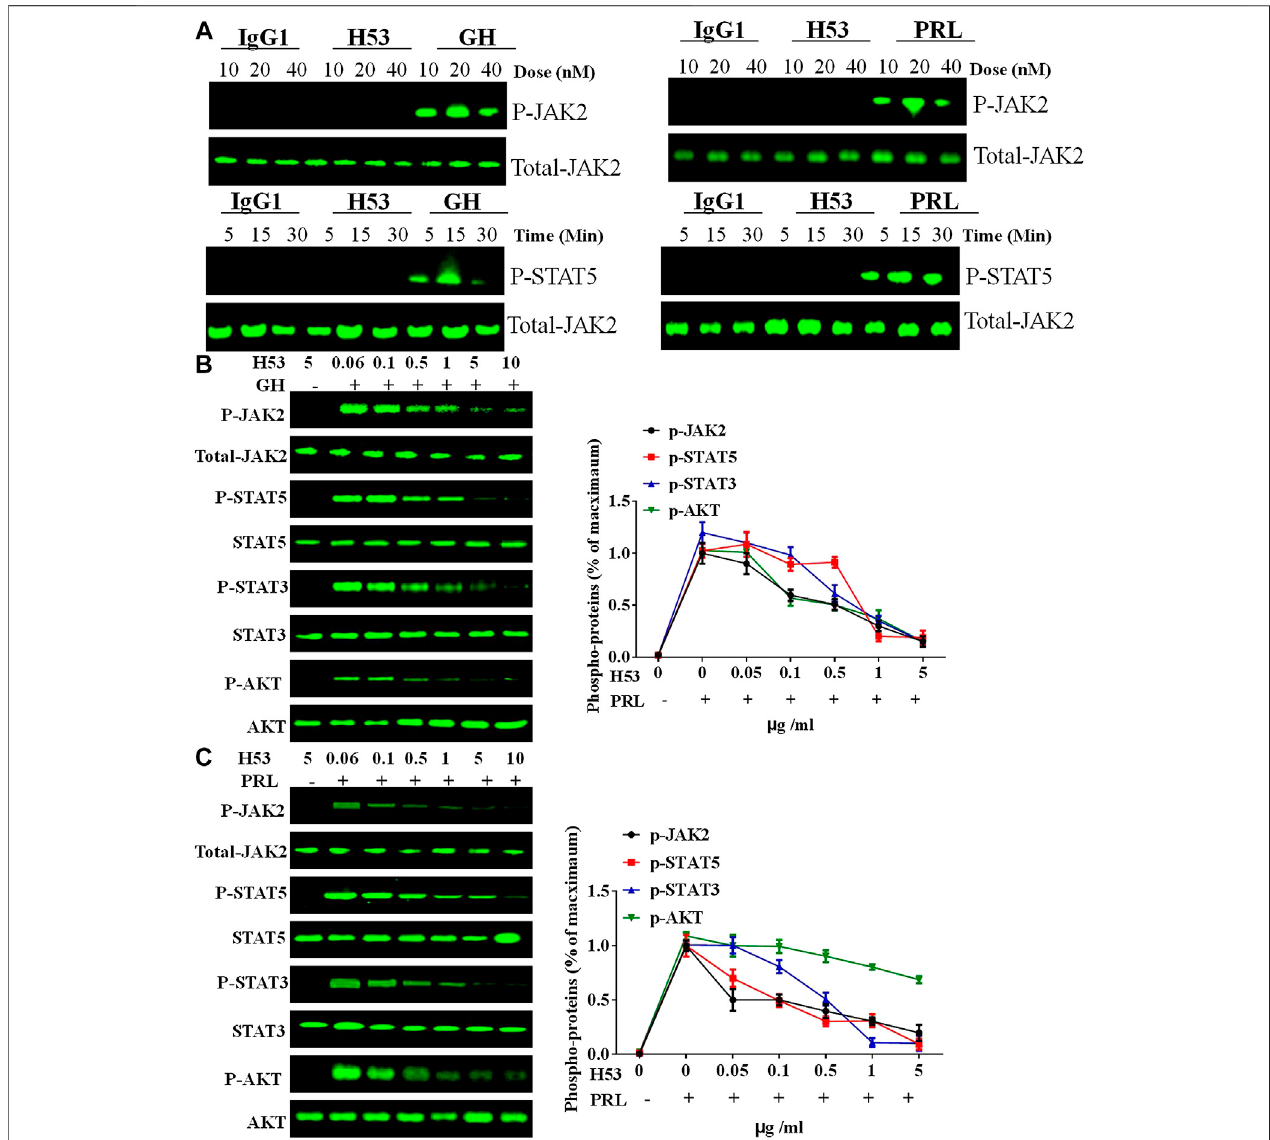
FIGURE 6 | (A) H53 has no agonistic activities. CHO-PRLR or CHO-GHR was starved for 6 h. The cells were washed with sterile PBS, and then stimulated with different concentrations of H53, IgG1 (isotype control) or PRL/GH (positive control). Western-blot analysis was then performed to measure proteins expression. (B) Inhibition of GH-induced signaling pathway by H53 but not control antibody. (C) Inhibition of PRL-induced signaling pathway by H53 but not control antibody. Results shownarerepresentativeofatleastthreeindependentexperiments.ImageJsoftwarewasusedtoquantifytheopticaldensityofproteinbands.Dataarepresented as the mean ± SD of three independent experiments. Cells challenged with PRL/GH alone were considered as 100%.